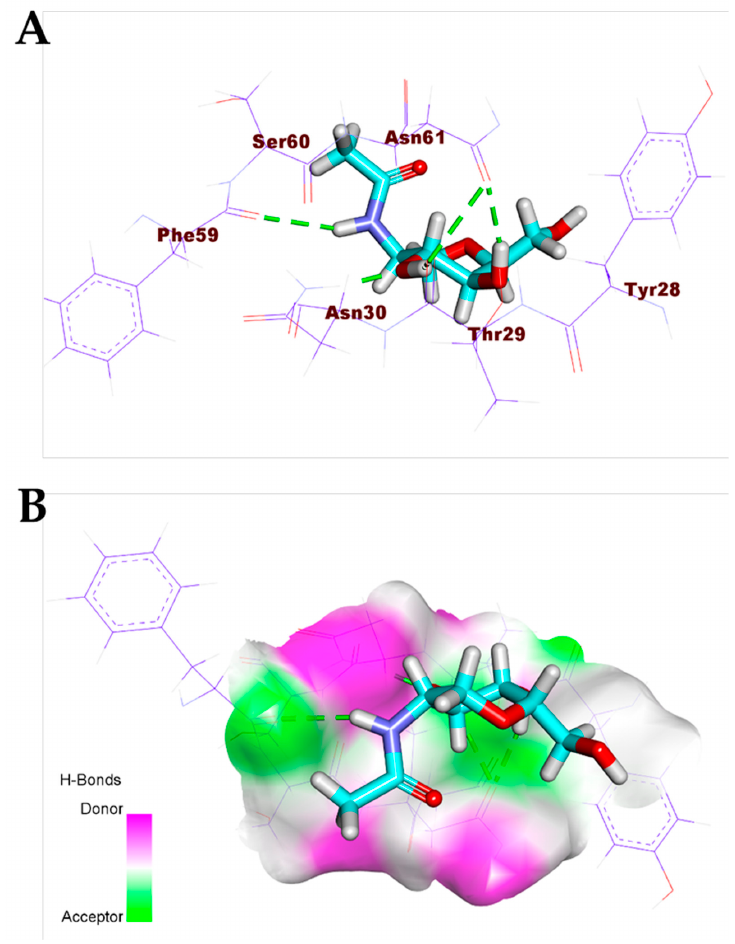
Figure 4 . ( A ) Co-crystallized ligand (NAG) docked into the active site of COVID-19 spike glycoprotein. ( B ) Mapping surface showing co-crystallized ligand (NAG) occupying the active pocket of COVID-19 spike glycoproteins.